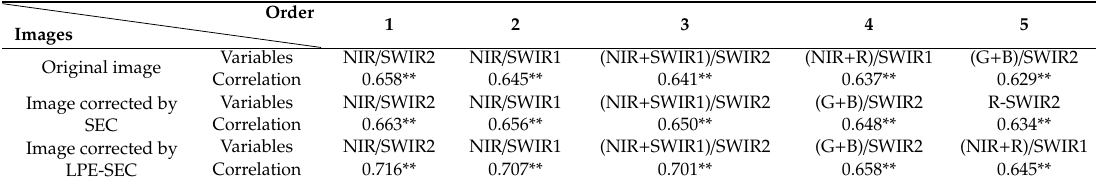
Table 7. Correlation coe ffi cients between the measured forest carbon density and spectral variables from the original images and the images corrected by the traditional SEC model and the LPE-SEC model,